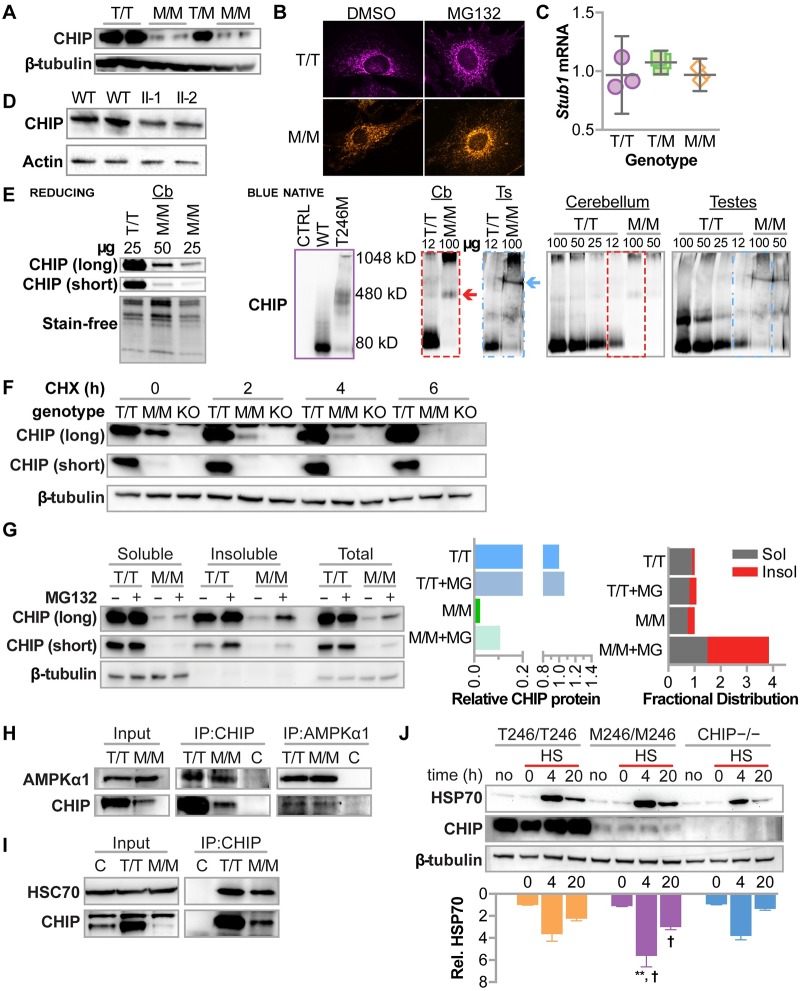
CHIP-T246M expressed from the endogenous locus results is regulated post-translationally resulting in decreased steady-state protein levels, however, interactions between CHIP and known interactors are not affected.(A) Immunoblot analysis of CHIP and β-tubulin protein in primary fibroblasts (MEFs) isolated from T246/T246 (T/T), T246/M246 (T/M), or M246/M246 (M/M) mouse embryos (B) Maximum intensity projections of CHIP immunofluorescence in MEFs treated with 0.05% DMSO or MG132. (C) qPCR analysis of Stub1 mRNA levels in MEFs represented by the dot plot and summarized by the mean and 95% confidence intervals. (D) Immunoblot analysis of CHIP and β-actin protein in fibroblasts isolated from control patients (WT) or siblings that are homozygous for CHIP-T246M (II-1 and II-2). (E) Immunoblot analysis of CHIP under reducing SDS-PAGE (left) or blue native PAGE (right) of varying amounts of protein extracts (μg) from cerebellum (Cbl) or testes (Ts) from mice with the indicated genotypes. Protein loading on the reducing blot was confirmed via stain-free technology. As a reference, migration of recombinant CHIP protein is provided (purple). The dashed boxes identify the regions used for longer exposure. (F) Immunoblot analysis of CHIP and β-tubulin in soluble cell lysates from either T/T or M/M, fibroblasts, or fibroblasts isolated from CHIP−/− embryos (KO) after exposure to cycloheximide (CHX) indicated in hours (h). Two exposures of CHIP immunoblots are provided to help visualize M/M conditions. (G) Immunoblot analysis of CHIP and β-actin in either the soluble or insoluble fraction of lysates or whole cell lysates from T/T or M/M MEFs treated with 20 μM MG132 or 0.05% DMSO control for 4 hours. (H) Immunoblot analysis of AMPKα1 and CHIP in cell lysates from T/T or M/M MEFs either before (input) or after immunoprecipitation (IP) of the indicated protein. Control samples (C) contained a mixture of 50% T/T and T/M and were immunoprecipitated with either rabbit IgG or goat IgG as controls for the CHIP and AMPKα1 antibodies, respectively. (I) Immunoblot analysis of HSC70 and CHIP in cell lysates from T/T or M/M MEFs either before (input) or after immunoprecipitation (IP) of CHIP. Control samples (C) contained a mixture of 50% T/T and T/M and were immunoprecipitated with rabbit IgG to control for the CHIP antibody. (J) Immunoblot analysis of HSP70 and CHIP in MEFs with the indicated genotypes that were treated without heat shock (no) or with heat shock (HS) followed by the indicated recovery time. Densitometry of relative HSP70 protein is represented by the bar graph and 95% CI, N = 3; **, † correspond to p < 0.01 or 0.05 via Tukey’s post hoc test comparing M/M to either T/T or CHIP−/−, respectively, at the indicated time point.